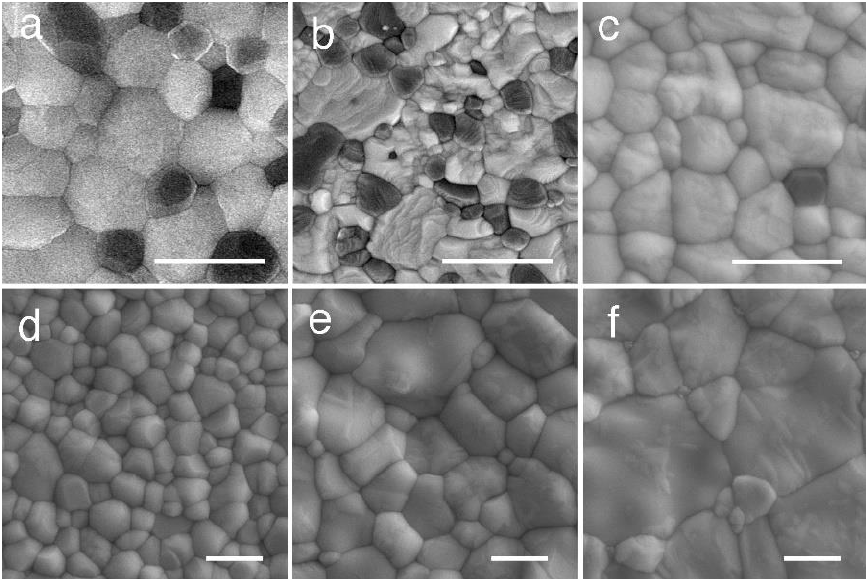
Figure 2. SEM photograph of dental zirconia illustrated in Figure 1. ( a ) alumina-toughened zirconia (ATZ); ( b ) Ce-TZP/alumina nanocomposite (NanoZR); ( c ) conventional TZP (3Y-HA); ( d ) high translucent TZP (3Y); ( e ) high strength PSZ (4Y); and ( f ) high translucent PSZ (5Y). White lines indicate 1 µm. Adopted from Refs. [3,5].